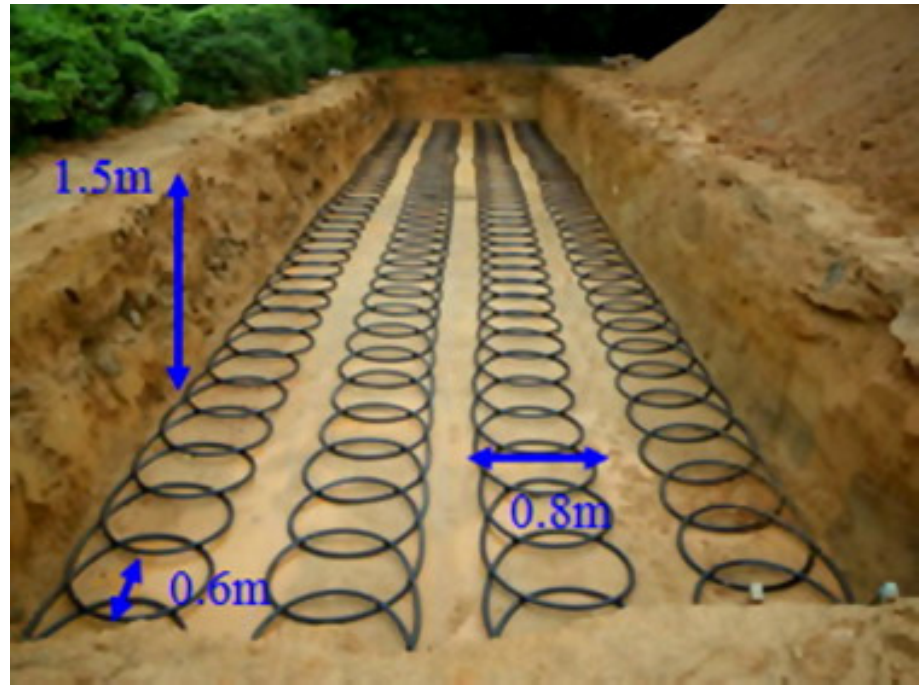
Figure 7. Slinky coil ground heat exchanger as shown by Fujii in [81].